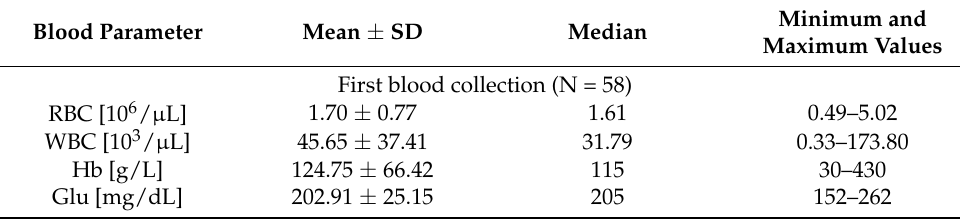
Table 1. Descriptive statistics and reference values of selected haematological parameters: RBC (red blood cell) and WBC (white blood cell) counts, Hb (haemoglobin) and Glu (glucose) levels in blood of free-living marsh harrier